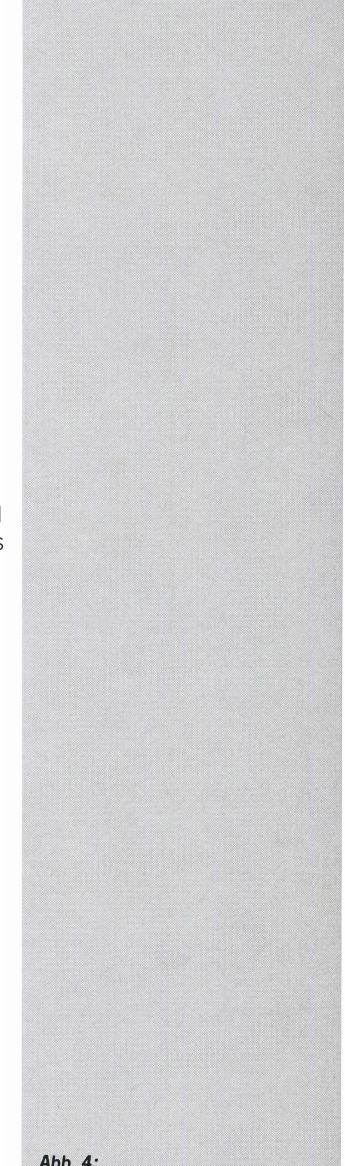
Fig. 4: Schematically drawing of a network from elongated flexible micelles